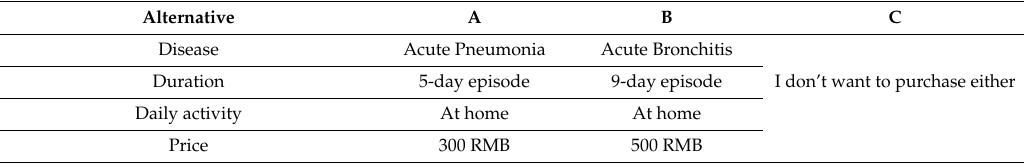
Table A12. Choice set